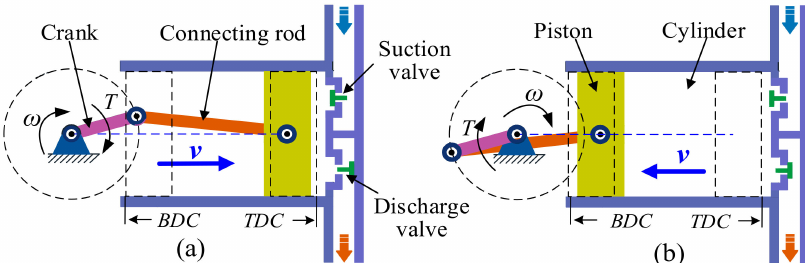
Figure 3. Schematic diagram of RC working process; ( a ) Positive stroke, and ( b ) Negative